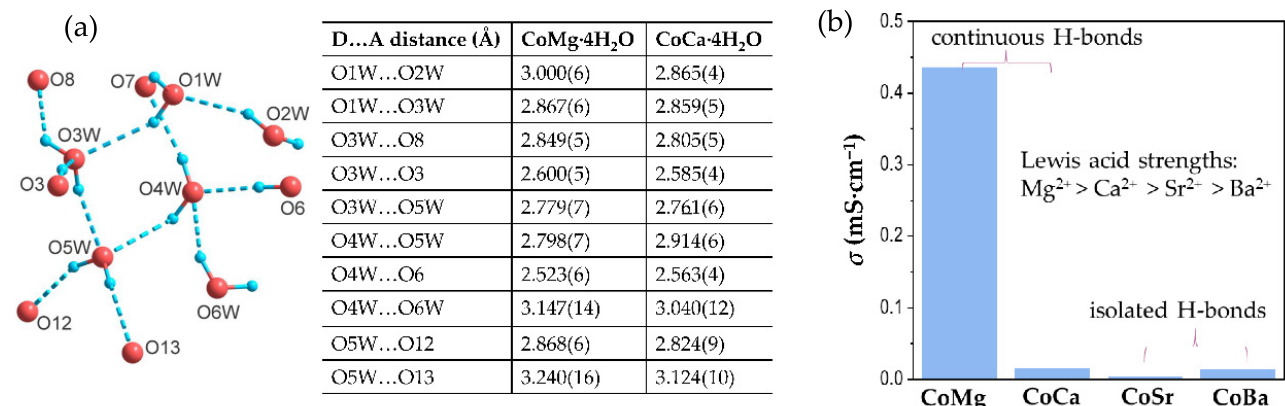
Table S2: Selected bond lengths (Å) and angles (°) for CoMg·4H 2 O ; Table S3: Selected bond lengths (Å) and angles (°) for CoSr·2H 2 O ; Table S4: Selected bond lengths (Å) and angles (°) for CoBa ; Figure S1: (a) Comparison of the observed and simulated powder X-ray diffraction patterns of CoMg·nH 2 O . (b) The observed pattern is fitted by the Pawley method using Topas 5.0 program; Figure S2: (a) Comparison of the observed and simulated powder X-ray diffraction patterns of CoSr·nH 2 O . (b) The observed pattern is fitted by the Pawley method using Topas 5.0 program; Fig- ure S3: Comparison of the observed and simulated powder X-ray diffraction patterns of CoBa ; Fig- ure S4: IR spectra of CoMg·nH 2 O , CoSr·nH 2 O, and CoBa ; Figure S5: Nyquist plots for the pellet of CoMg·nH 2 O at 25 °C and various RH; Figure S6: Nyquist plots for the pellet of CoMg·nH 2 O at 25 °C and various RH; Figure S7: Nyquist plots for the pellet of CoMg·nH 2 O at 95% RH and various temperatures; Figure S8: Nyquist plots for the pellet of CoSr·nH 2 O at 25 °C and various RH; Figure S9: Nyquist plots for the pellet of CoSr·nH 2 O at 25 °C and various RH; Figure S10: Nyquist plots for the pellet of CoSr·nH 2 O at 95% RH and various temperatures; Figure S11: Nyquist plots for the pellet of CoBa at 25 °C and various RH; Figure S12: Nyquist plots for the pellet of CoBa at 25 °C and various RH; Figure S13: Nyquist plots for the pellet of CoBa at 95% RH and various temperatures.